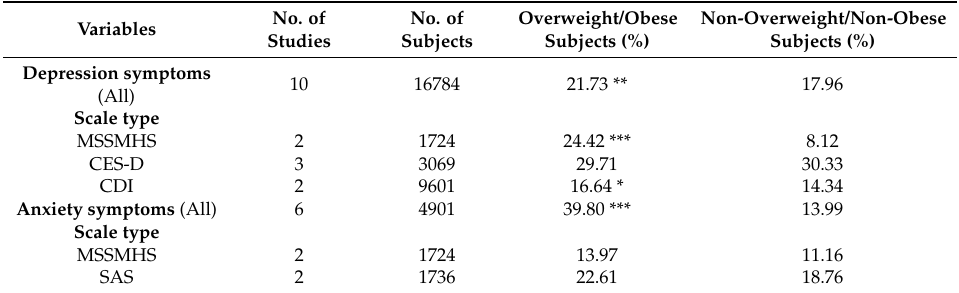
Table 3. Unadjusted prevalence of depression and anxiety symptoms in children/adolescents with and without